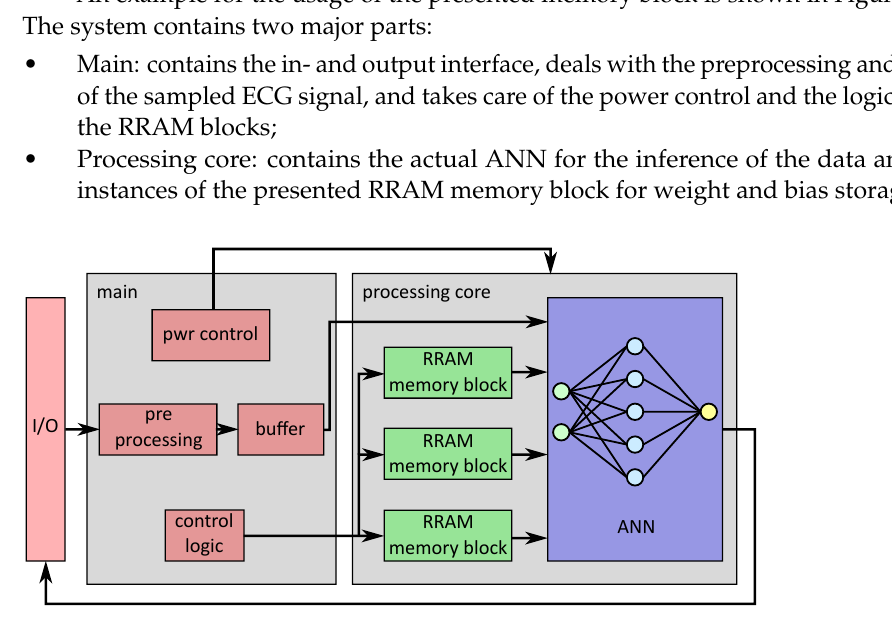
Figure 1. Overview of a system utilizing ANN (blue) and the presented RRAM memory block (green) for AFib detection in sampled ECG signals. The RRAM memory blocks store the weight and bias values for the ANN in a non-volatile way to enable power gating for the processing core in general and the memory blocks individually after loading the values into the ANN